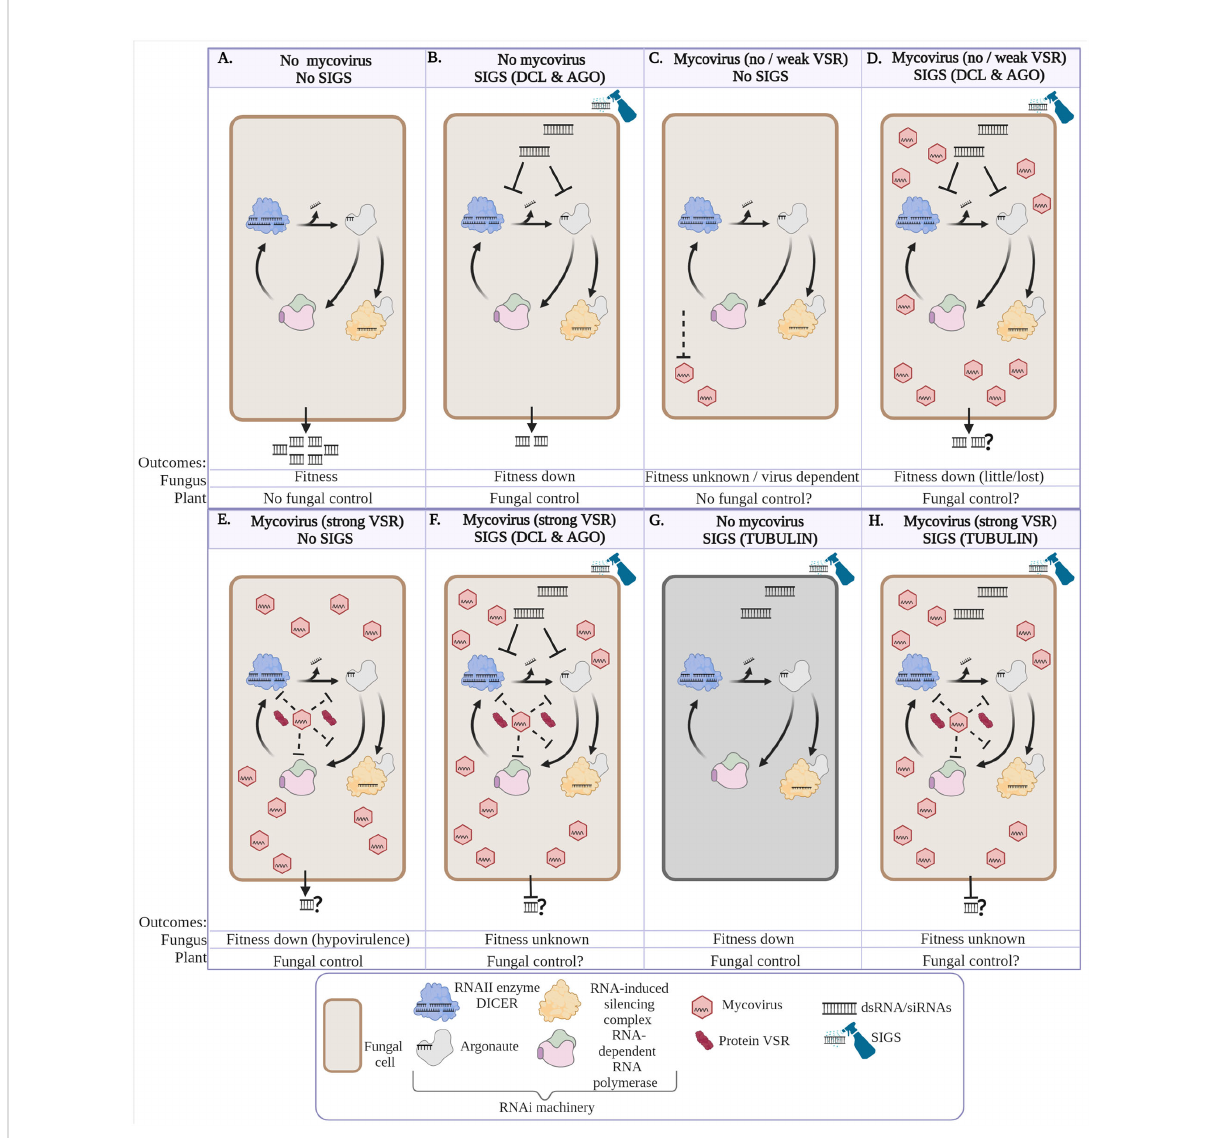
FIGURE 1 Various scenarios depicting the impact of fungal control using spray-induced gene silencing (SIGS) targeting fungal silencing machinery and mycovirus infection. These scenarios are particularly relevant for those fungi that produce dsRNA to target the host defence response. (A) Fungus produces either double stranded RNA (dsRNAs) and/or small interfering RNAs (siRNAs) to suppress host plant immunity or regulate virulence genes (effectors). (B) The dsRNAs and/or siRNAs from SIGS are taken up by a fungus and processed by RNAIII enzyme, DICER. Then, Argonaute (AGO) and RNA-induced silencing complex (RISC) include one siRNA strand that guides silencing of DCL1/2 and AGO1/2 messenger mRNA (mRNA). Alternatively, siRNAs prime RNA-dependent RNA polymerase (RdRP) to create more dsRNA that ampli fi es the RNAi machinery to target more DCL1/2 and AGO1/2 mRNAs. In scenario B the RNAi activity in the cell will be reduced resulting in few siRNA required for pathogenesis. If the fungus relies on siRNAs as key secreted virulence factors, then fungal fi tness and pathogenicity will be reduced. (C) Fungus is infected by mycovirus with no or weak virus-encoded suppressors of RNAi (VSRs) resulting in mycovirus replication that is limited by active fungal host RNAi (dependent on speci fi c mycovirus and fungal host interaction). (D) This scenario depicts the combinations of A and B, where the fungus has a mycovirus and SIGS targets either DICER or AGO resulting in reduced antiviral activity, increased mycovirus replication and reducing fungal virulence compared with scenario (C) virulence. (E) Mycovirus produces VSRs to deactivate the fungal RNAi machinery (DICER, AGO, RdRP or other RNAi targets/activities), resulting in mycovirus accumulation and reduction in fungal fi tness. (F) Depicts a scenario of a fungus with SIGS (targeting DICER and AGO) and a mycovirus encoding strong VSR activity; the outcome is unknown, and probably dependent on a balance between mycovirus, VSR activity and strength, and the ef fi ciency of the dsRNA to achieve silencing. (G) Depicts a fungus with SIGS applied to target b -tubulin (a protein not involved in RNAi). Fungal death results from the inhibition of tubulin polymerization. (H) depicts a scenario that combines E and G whereby the fungal cell is infected with a mycovirus with strong VSR activity and tubulin polymerization is inhibited via RNAi. Fitness of the fungus in this scenario will depend on the balance between SIGS-induced RNAi ef fi cacy and VSR deactivation of the RNAi machinery similar to scenario (F) . The illustration was created with